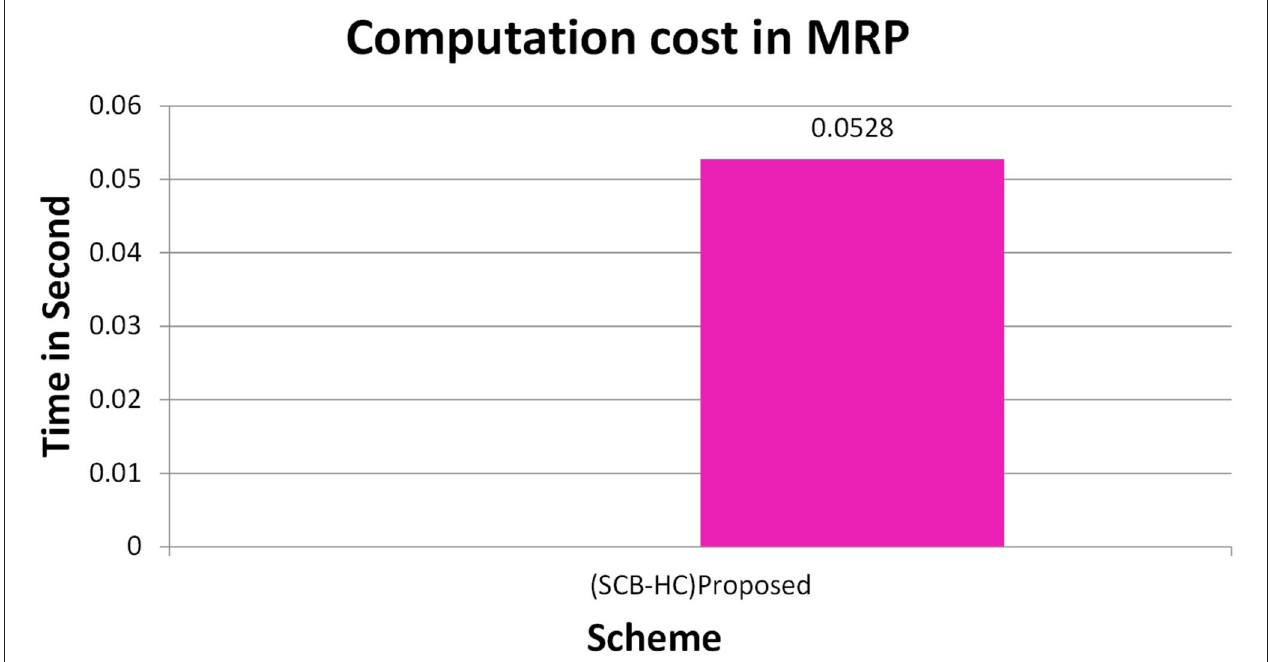
FIGURE 4 | MRP computation cost.